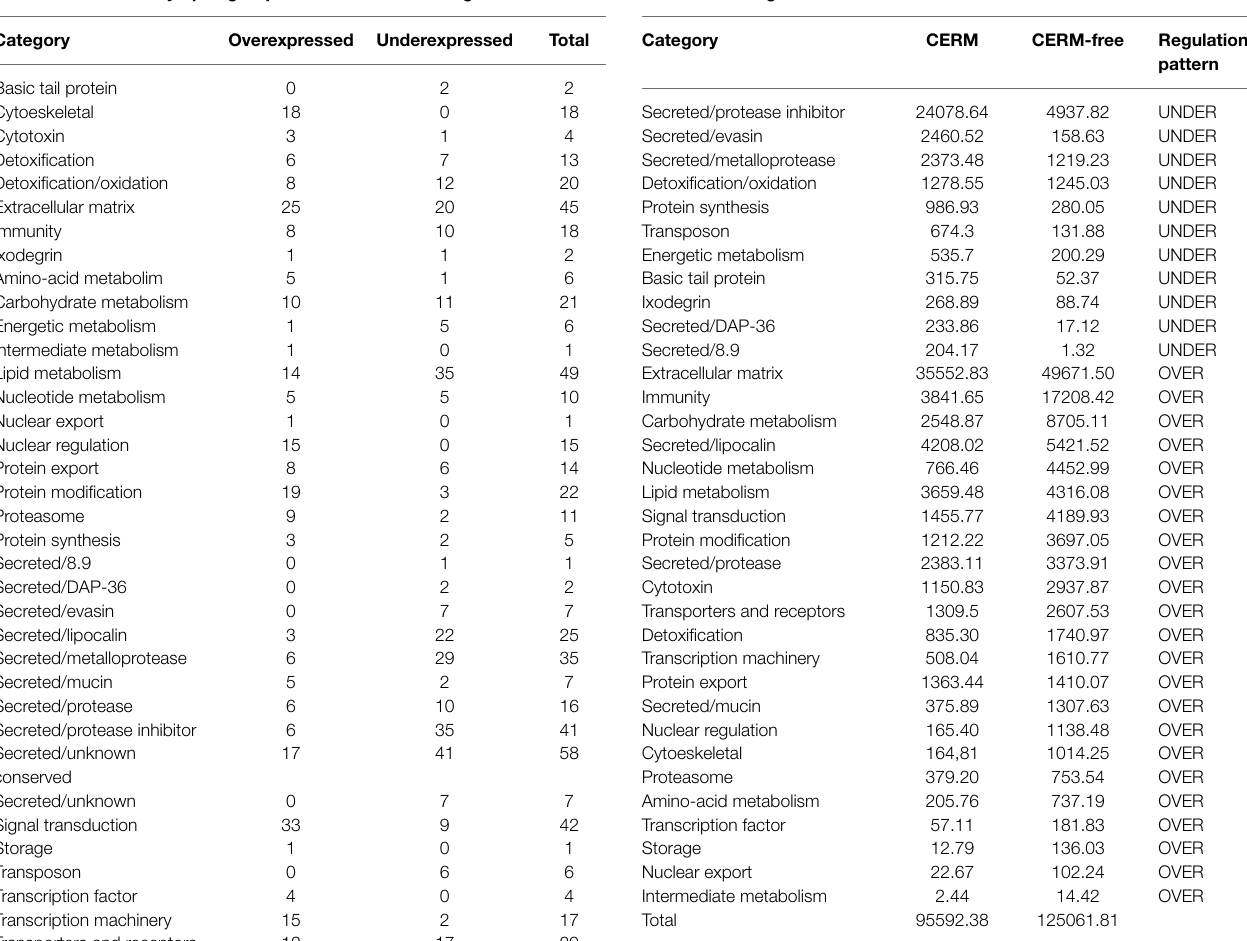
TABLE 2 | Total TPM (transcripts per million) in each functional category for the differentially expressed transcripts in CERM ( Coxiella endosymbiont from R. microplus )-free metanymphs.